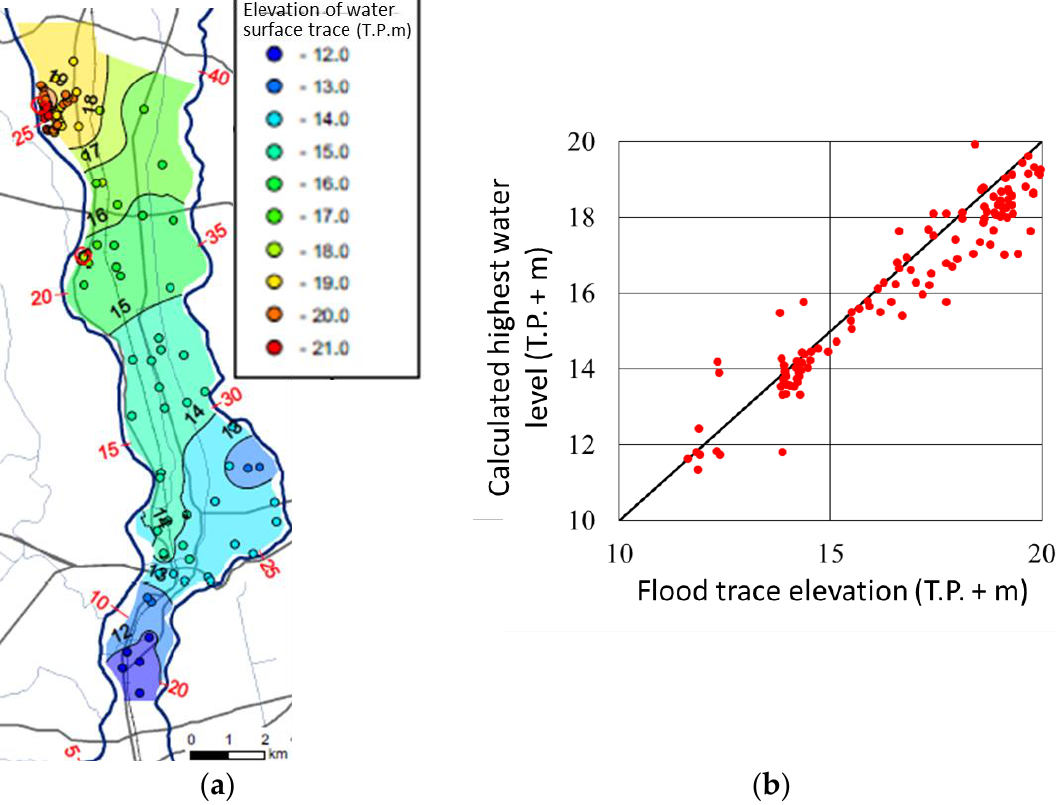
Figure 15. Reproducibility of highest water levels for 2015 flood; ( a ) highest water level obtained from flood trace and ( b ) correlation between observed and calculated water